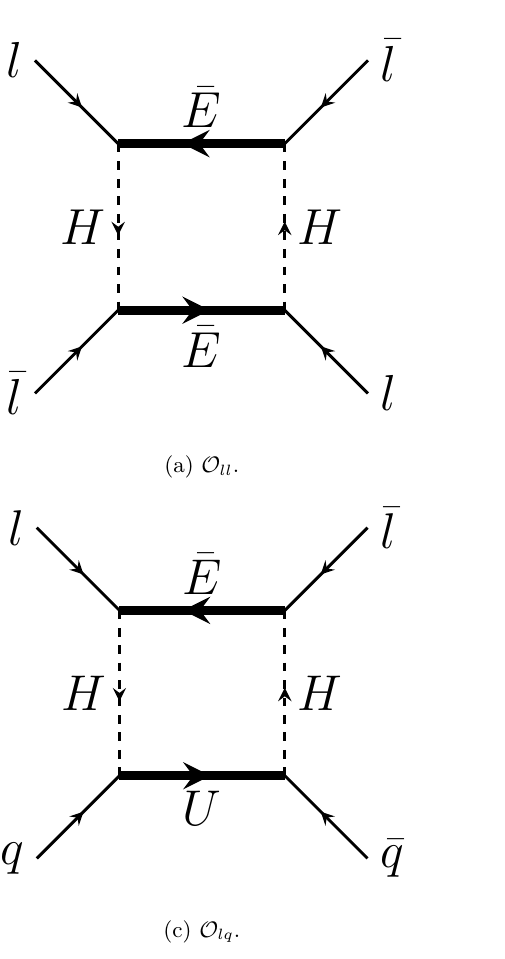
Figure 8. Minimal models for the operators O ll , O qq and O lq